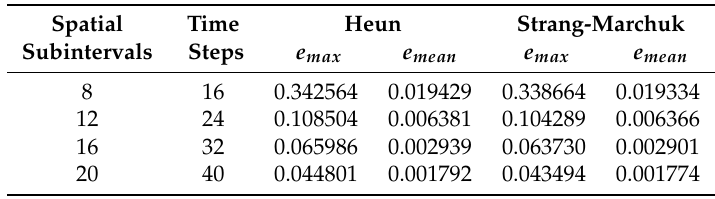
Table 10. Differences between the analytical solution of convection–diffusion–reaction (CDR) equation and the numerical solutions obtained by direct (Heun) integration and by Strang–Marchuk method with different number of spatial subintervals.